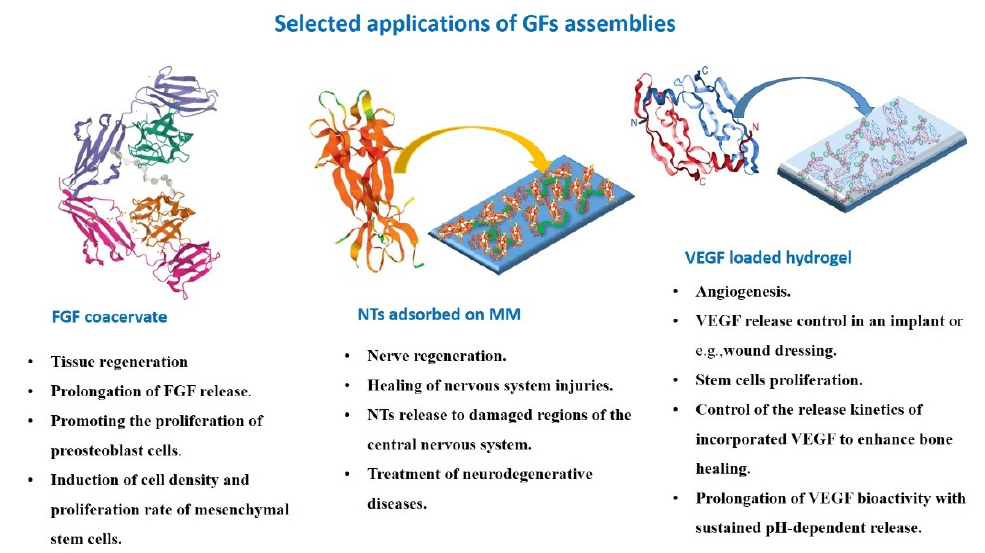
Figure 5. Various macroion/growth factor assemblies and their applications.